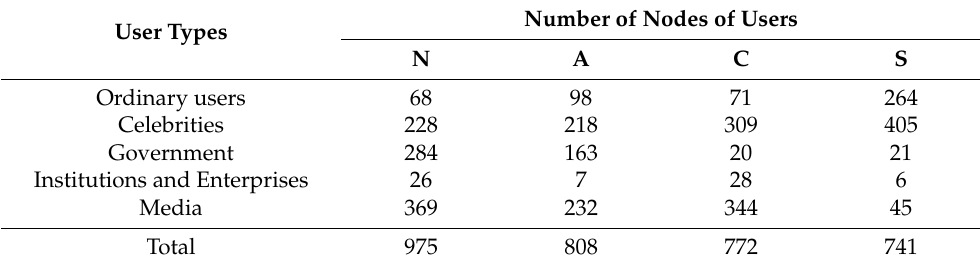
Table 3. The numbers of user types at each